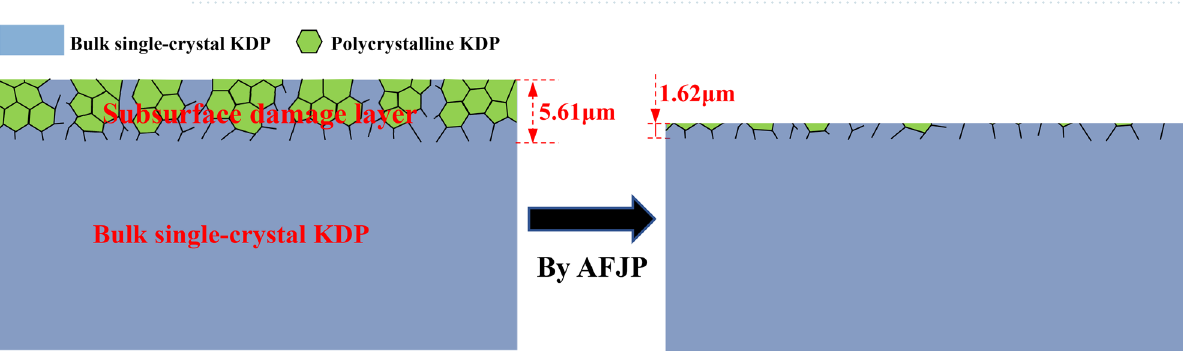
Figure 17. The schematic microstructure of subsurface damage layer of (010) SPDT surface before and after